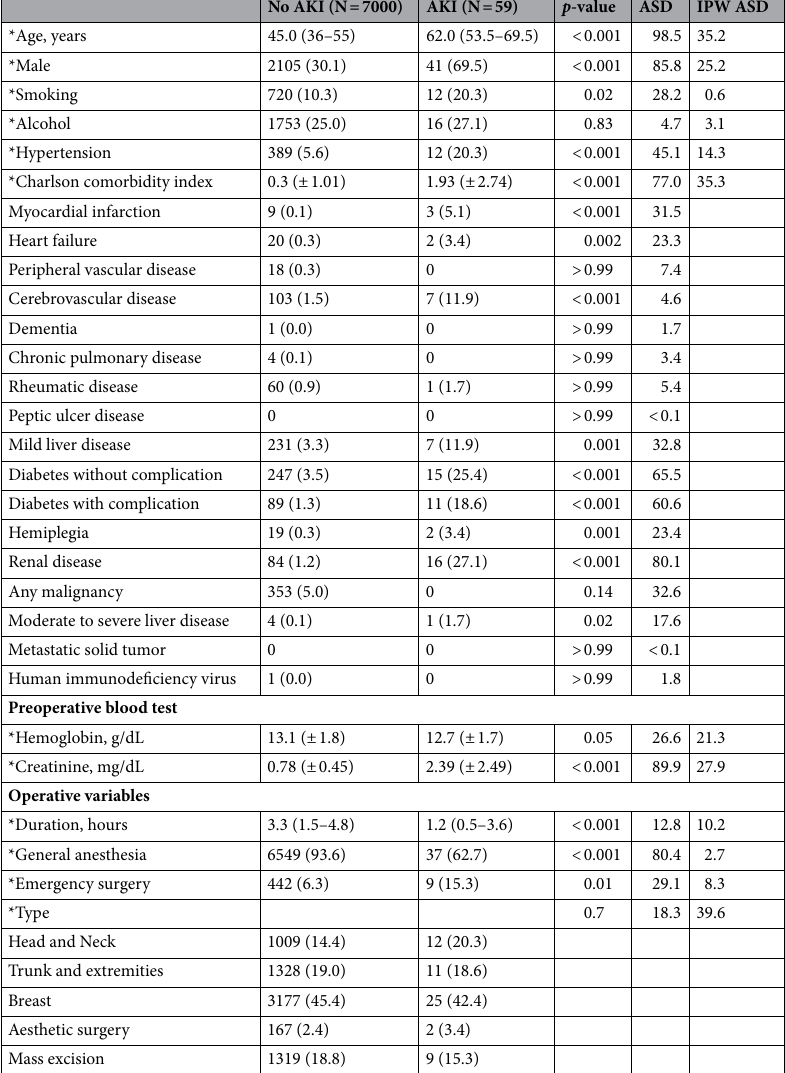
Table 1. Baseline characteristics according to postoperative acute kidney injury (AKI). Values are n (%), mean (± standardized difference), or median (interquartile range). ASD absolute standardized mean difference, IPW inverse probability weighting. *Following variables were retained for IPW adjustment.